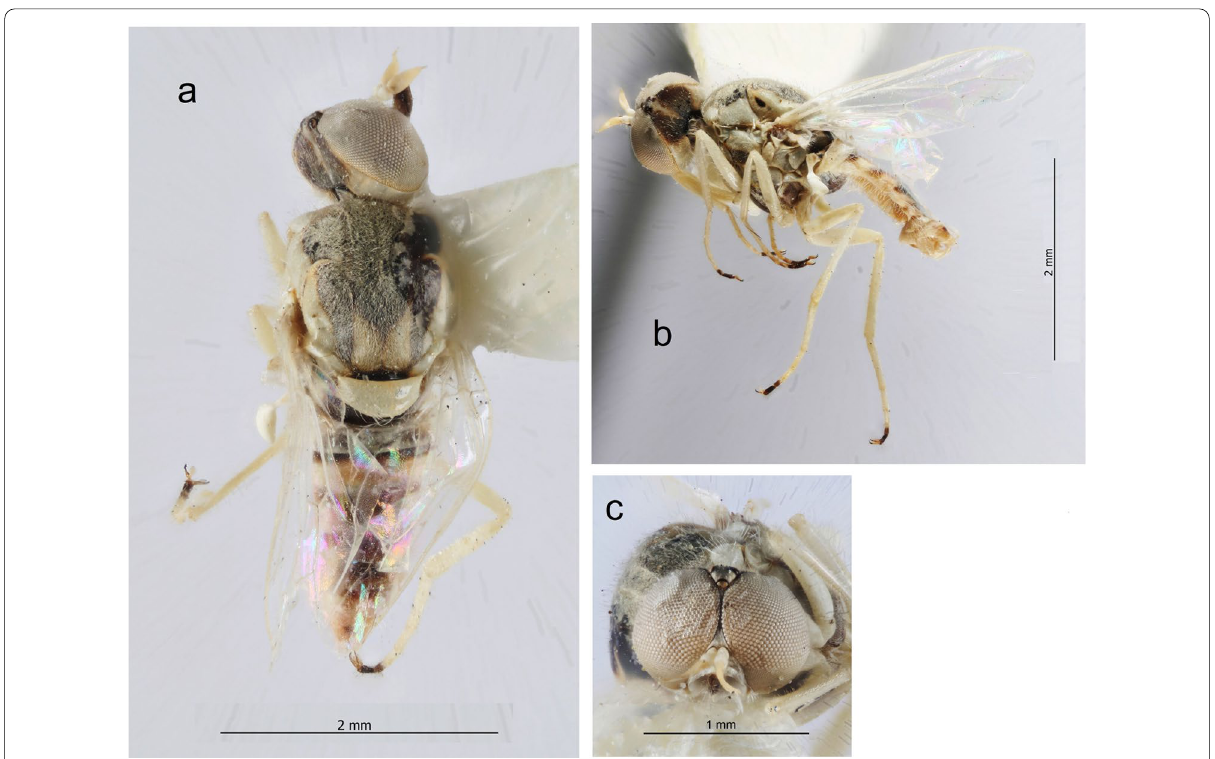
Fig. 1 Heterotropus bisglaucus Bezzi. a Male habitus, dorsal view. b same, lateral view. c Head, frontal